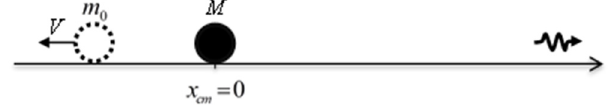
Fig. 2. The atom emits a photon reducing the mass and recoils to